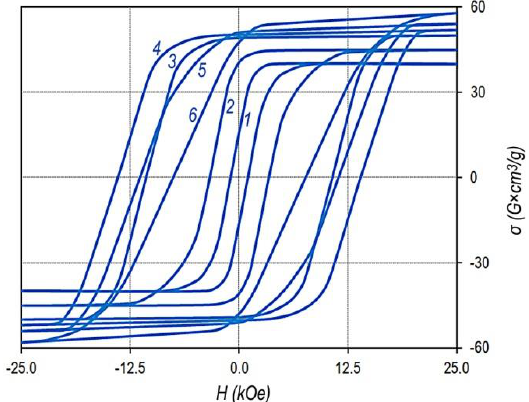
Figure 11. Major hysteresis loops of pseudo-single crystal samples of Gd 0.85 Zr 0.15 (Co 0.70 Cu 0.09 Fe 0.21 ) Z alloys with z = 5.2(1), 5.6(2), 6.0(3), 6.2(4), 6.4(5), and 6.8(6); VSM, without allowance for the demagnetizing factor, N = 1/3); compilation of data of Lyakhova et al. [11].